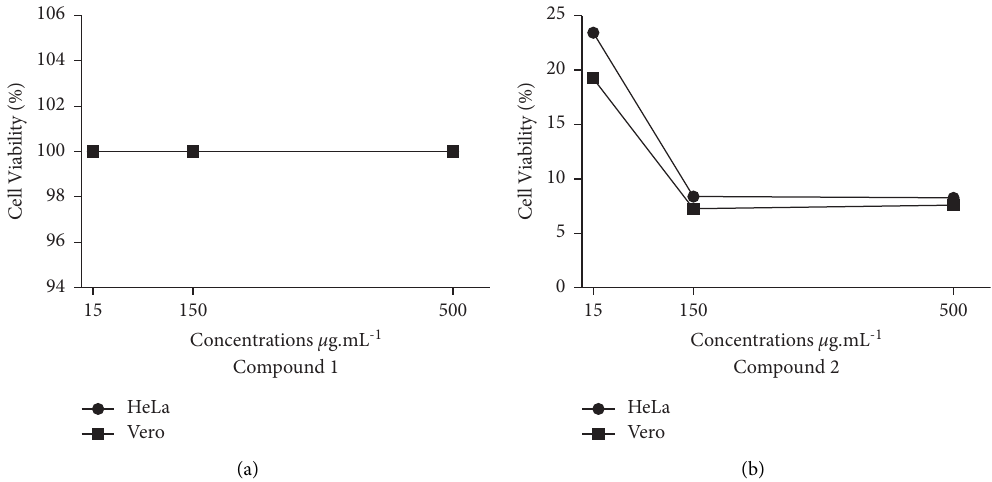
Figure 3: Percentage of cell viability of HeLa and Vero cell lines treated with different concentrations of 4, 5-dihydro-1H-pyrazole-1- carboximidamide hydrochlorides (trifluoromethyl)phenyl-substituted, compound 1 , and bromophenyl-substituted, compound 2